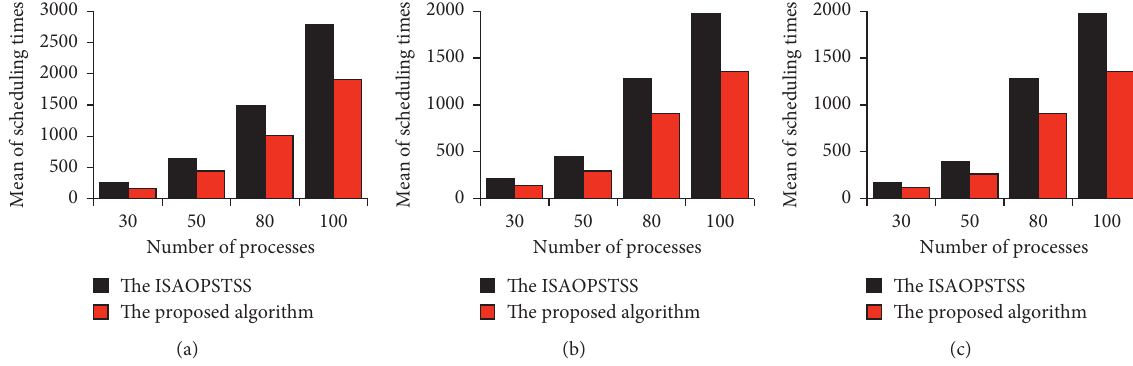
Figure 10: The comparison chart of the average scheduling times when the total number of devices is 3, 6, and 9, respectively. (a) Comparison chart of mean scheduling times when the number of devices is 3. (b) Comparison chart of mean scheduling times when the number of devices is 6. (c) Comparison chart of mean scheduling times when the number of devices is